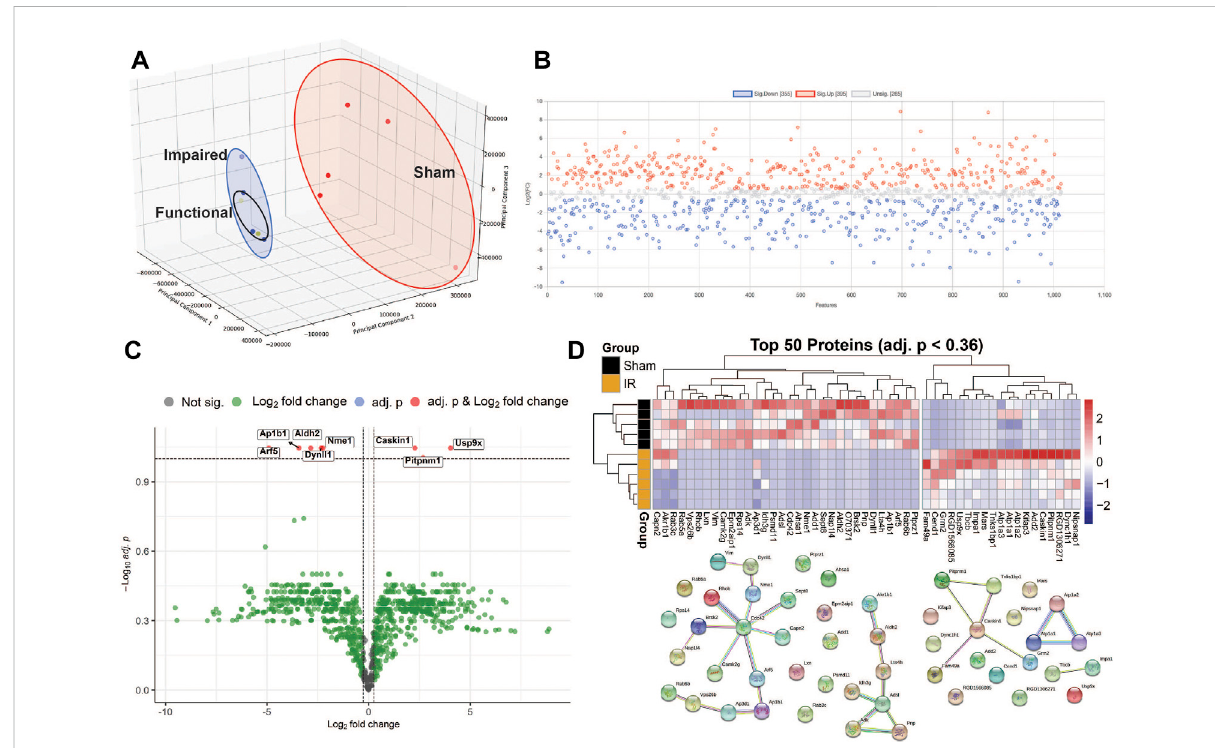
FIGURE 2 Multivariate data analysis. Panel (A) A 3D PCA scores plot shows that radiation is the main driver of the proteomic differences. Panel (B) Fold changes (1.5 cut-off) between exposed and sham. Panel (C) Volcano plot of exposed vs sham with fold-change of 1.5 cut-off and an FDR p -value of < 0.1. Panel (D) Heatmap of the top 50 proteins and STRING network analysis of those proteins.